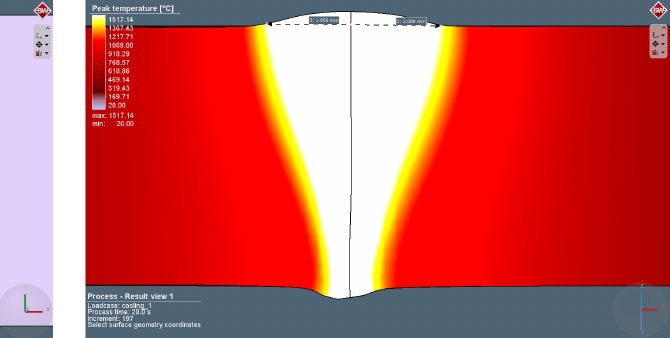
Figure 2: Overview of laser welding process of dissimilar butt joint was performed according to established boundary condi- tions (Figure 2).